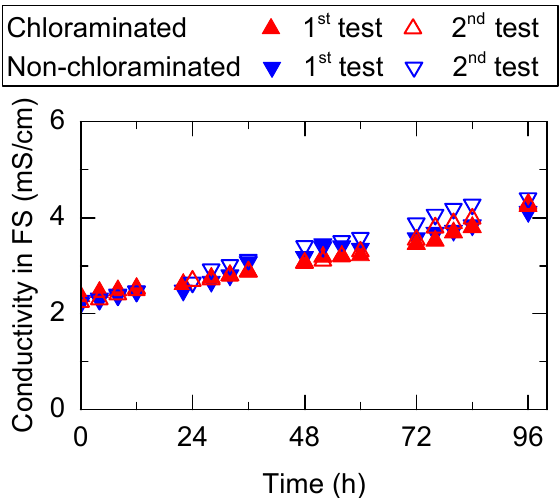
Figure 5. Conductivity in the FS during the pre-concentration of primary wastewater effluent using a FO membrane. Conductivity in the draw solution (DS) was maintained at 47 mS/cm for all tests.